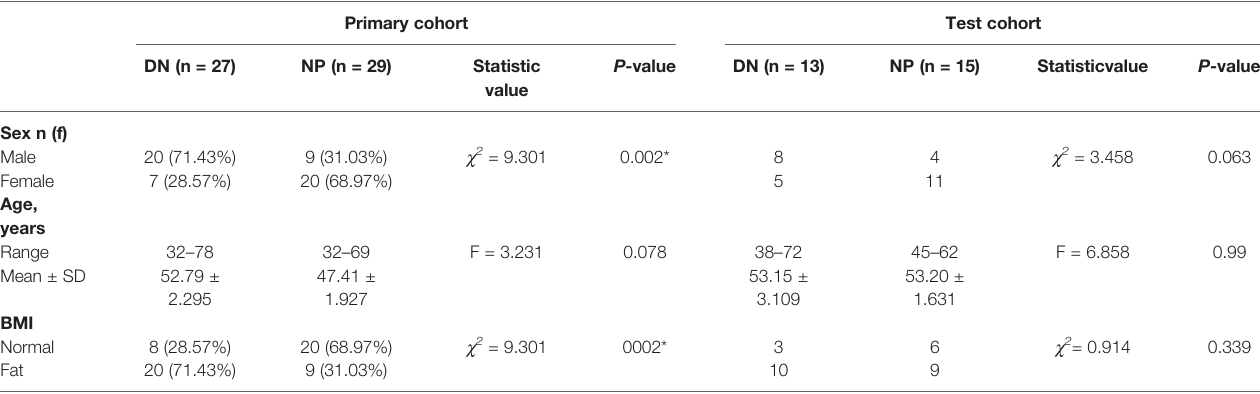
TABLE 1 | Patient characteristics in the primary and test cohort (n =